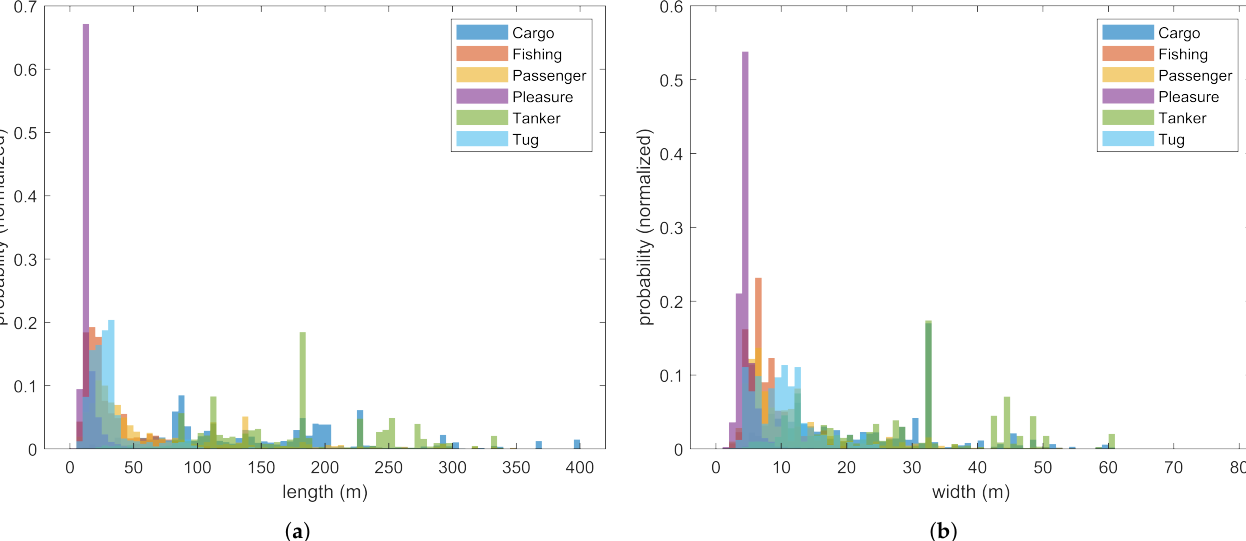
Figure 4. Training data ( AIS C ) ( a ) length distribution (grouped into bins of 5 m) and ( b ) width distribution (grouped into bins of 1 m) for each ship